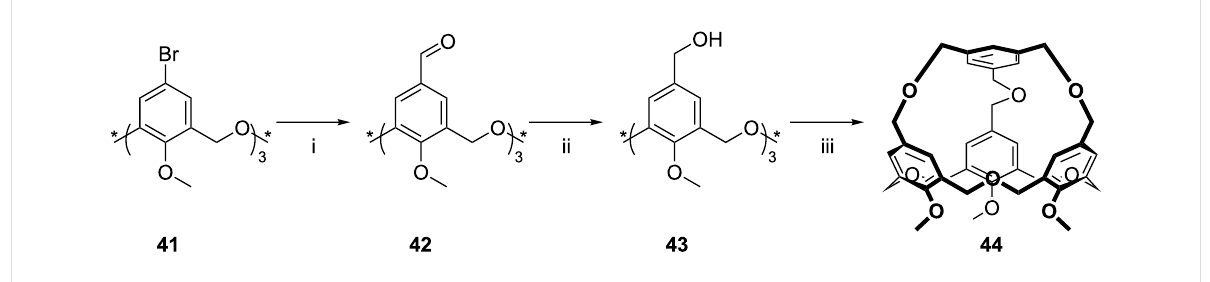
Scheme 19: Capping the upper rim: (i) t -BuLi, THF, − 78 °C; (ii) NaBH 4 , THF/EtOH; (iii) 1,3,5-tris(bromomethyl)benzene, Na 2 CO 3 , DMF